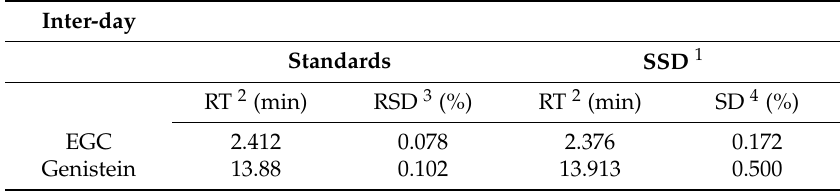
Figure 1. HPLC analysis of Spatholobus suberectus Dunn (SSD). In order to obtain efficient chromatographic methods for the analysis of ( c ) SSD compared with ( a ) epigallocatechin (EGC) or ( b ) genistein in accordance with the retention time and UV-Vis wavelength, an Agilent series 1290 system was used. To exhibit efficient separation and reasonable results, intra-day and the inter-day analyses were conducted in the same day and on consecutive three days, respectively. The gradient eluent condition resulted in a satisfactory separation. The relative standard derivations (RSDs) were deliberated to indicate the level of precision. Table 1. Measurement repeatability of intra-day precision and inter-day precision was performed against reference standards; the percentage of RSD of six assay results was calculated.